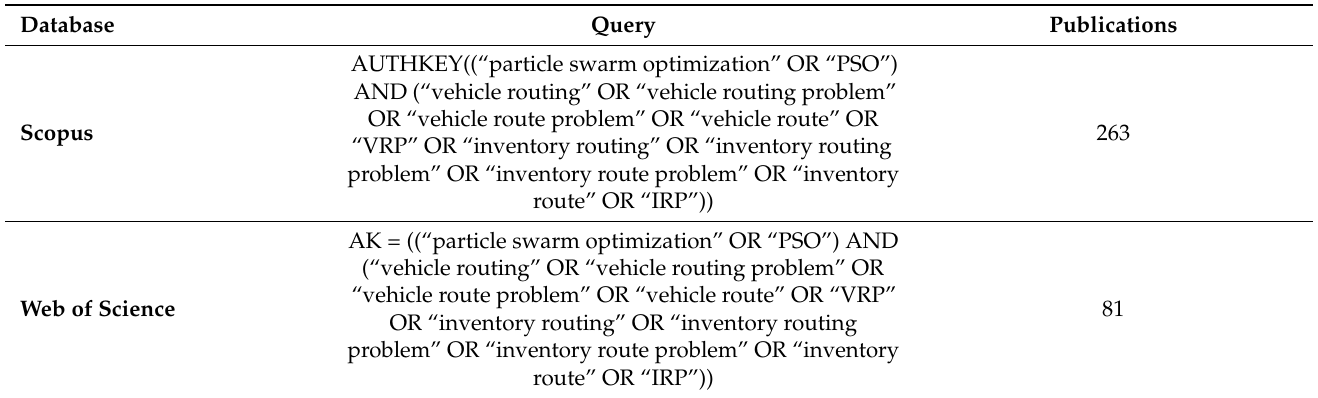
Table 2. Adapted search query strings.